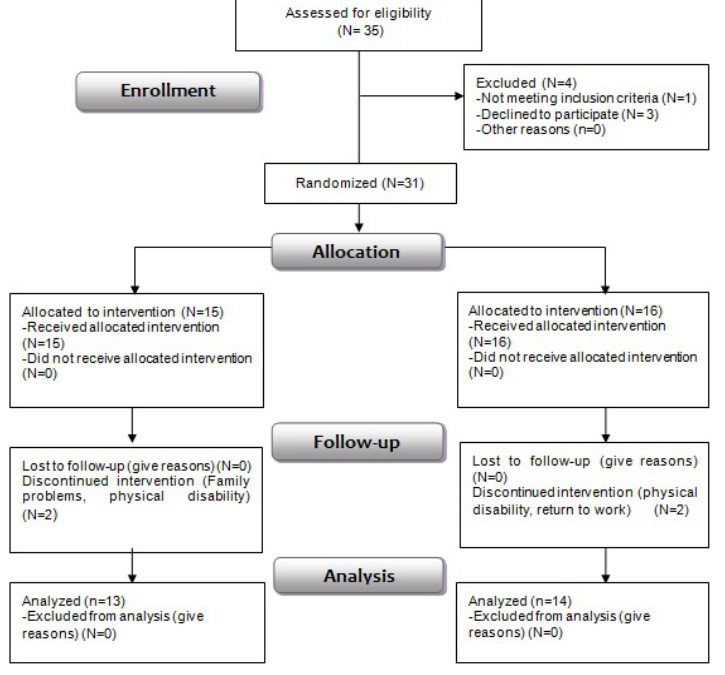
Figure 1. CONSORT flow diagram of research participants’ allocation[21].